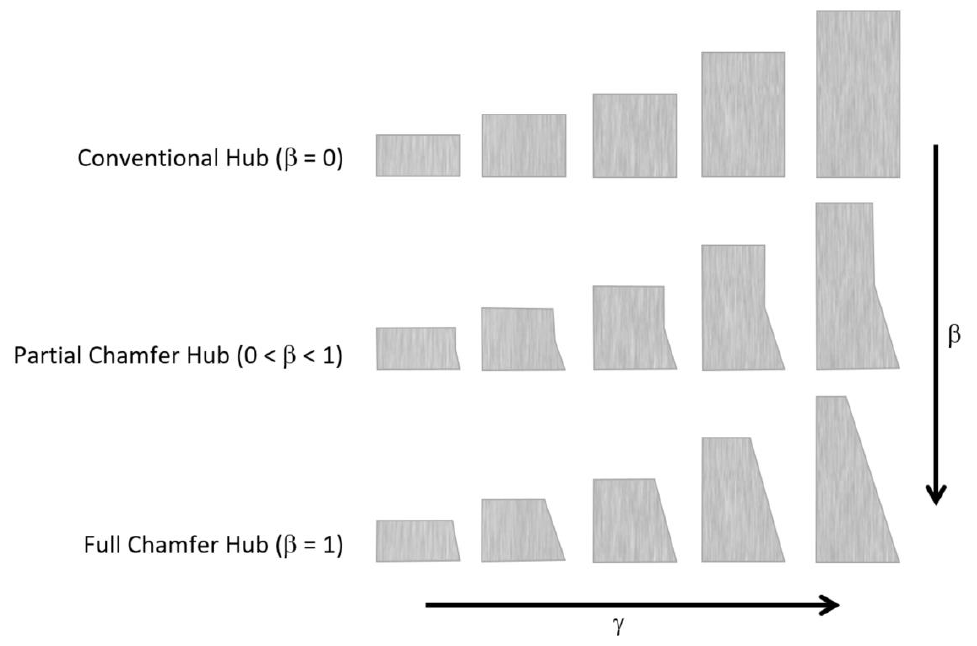
Figure 2. Scheme of the geometric modifications of the hub in terms of the dimensionless parameters used in this study: the chamfer height β and the hub thickness γ .